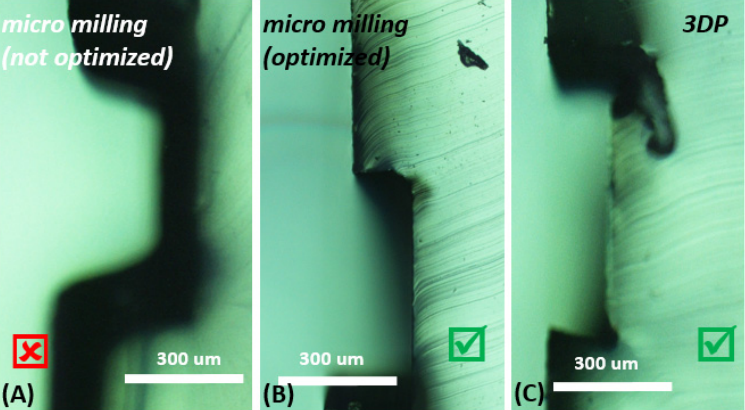
Figure 2. Inspection of the microfluidic channel from the cast elastomer under a wide-field upright microscope. ( A ) Microfluidic chip from the micro-milling mold (not optimized). It shows the